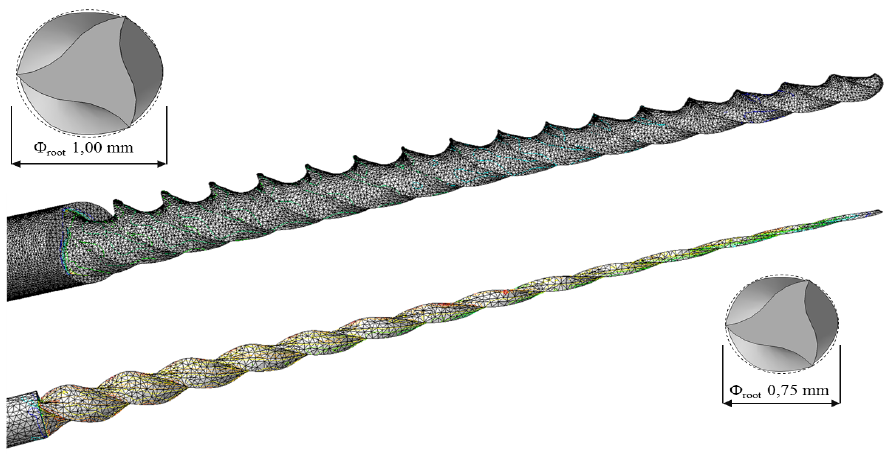
Figure 3: Detail of the root cross section of the 3D model and the tetrahedral meshes.